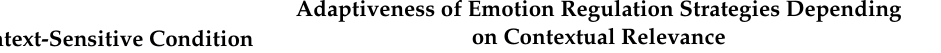
Table 1. Examples of the potential adaptiveness of various emotion regulation strategies depending on five context factors. Situations A and B represent hypothetical examples of different oncological scenarios. Varying situations result in varying perceptions of these five factors (e.g., low vs. high degree of controllability), which in turn affect agency and afford the use of varying strategies. Different regulatory strategies are underlined. Patient’s introspections are in italics. In this table the underlined regulatory strategies are always adaptive (based on the model of emotion regulation flexibility